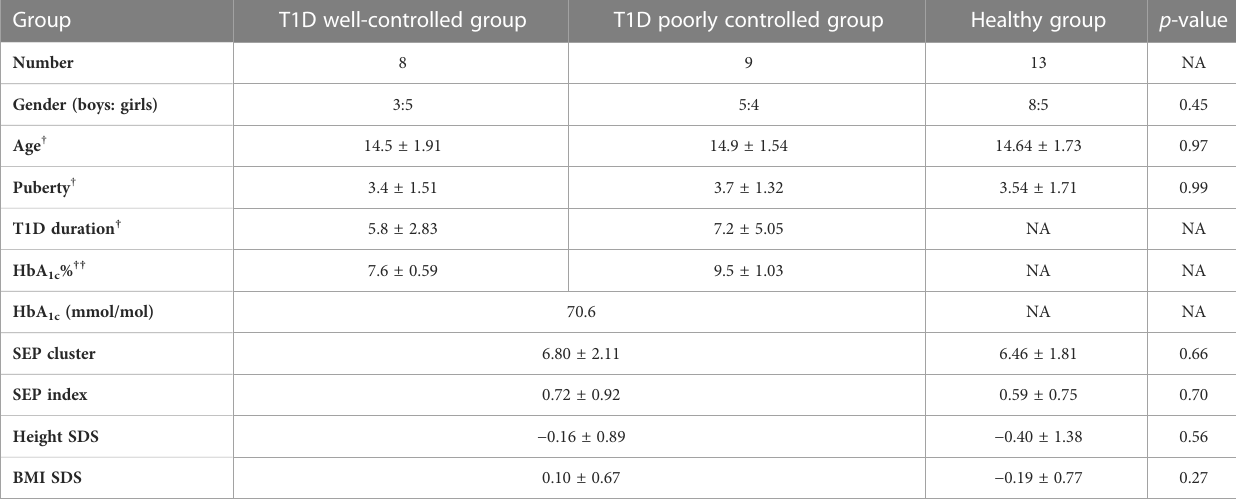
TABLE 1 Statistics: Clinical and demographic characteristics of the study population.